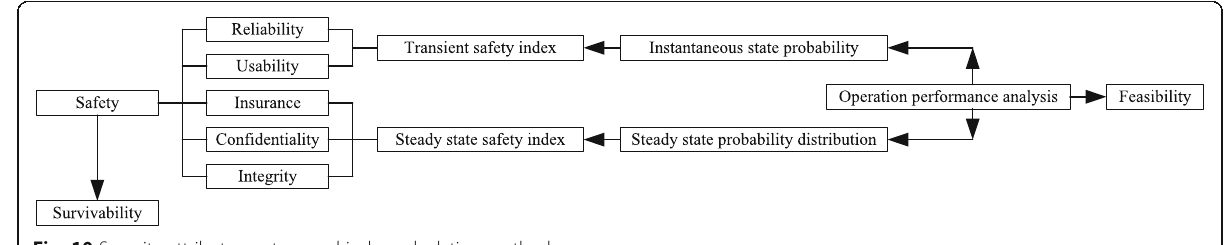
Fig. 10 Security attributes system and index calculation